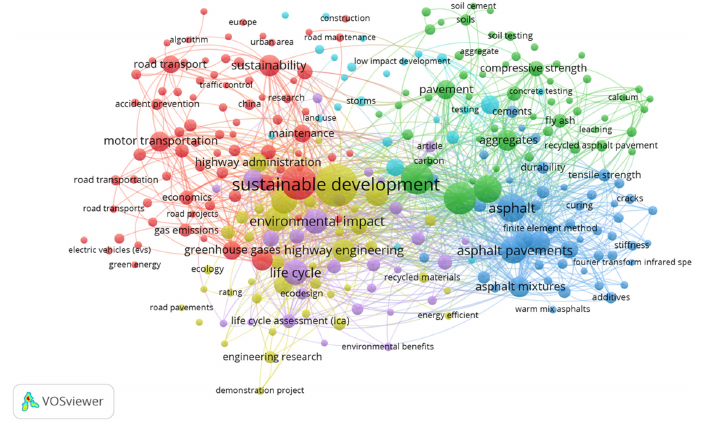
Figure 6. The network mapping of keyword co-occurrences.